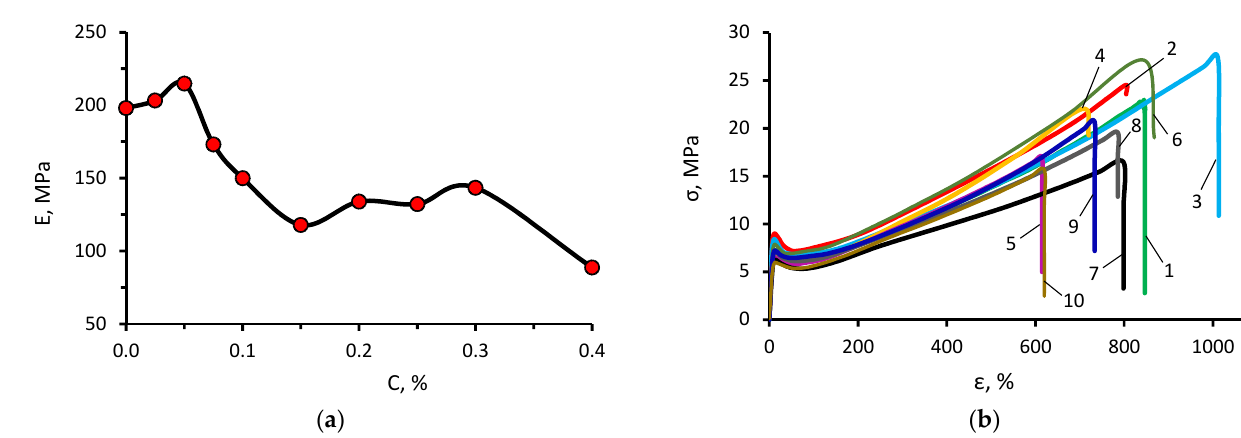
Figure 10. Dependence of Young’s modulus (E, MPa) of polymers on the content of the ASiP–AGM-10 in their composition ( a ) and tensile tests ( b ) of polymers obtained at [ASiP–AGM-10] = 0.0 (1), 0.025 (2), 0.05 (3), 0.075 (4), 0.10 (5), 0.15 (6), 0.20 (7), 0.25 (8), 0.30 (9), 0.40 and (10) wt.%.